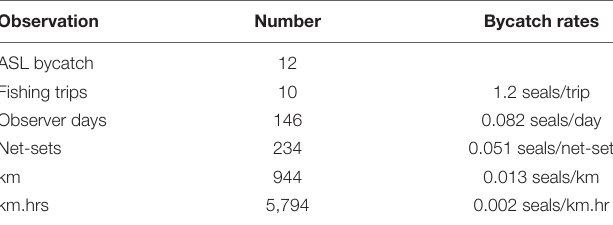
TABLE 2 | Summary of the independent observer data collected in the shark gillnet GHAT fishery between February 2006 and February 2008.